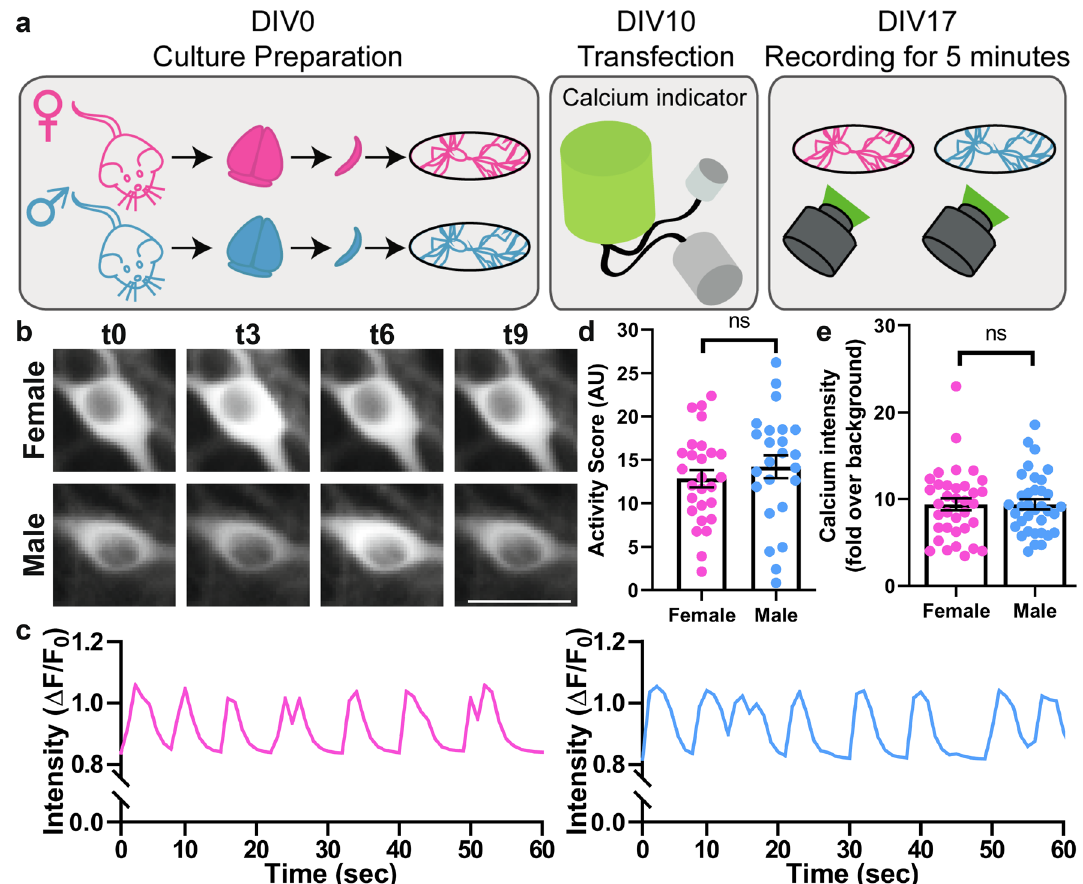
Figure 4. The spontaneous network activity does not show any sex-related differences. (a) To be able to study the sex-related differences in primary culture, we separated female and male neurons during the culture preparation. To determine the spontaneous firing rate, we transfected the neurons at day in vitro 10 (DIV10) with the genetically-encoded Ca 2+ indicator NeuroBurst. At DIV17, we imaged neurons for 5 min. (b) Exemplary 9 s-long calcium signals (t0-t9) images of female and male neurons. Scale bar: 20 µm. (c) Example calcium signals in male and female neurons, normalized to the baseline (ΔF/F0). (d) To compare the spontaneous calcium activity between the two sexes, we calculated the area under the curve of the intensity graphs, which we termed “activity score”, over 6 independent culture preparations that have 6 coverslips for each sex (N = 6, n = 36 independent experiments). The graph presents the activity score (mean ± SEM) and each symbol represents the mean activity score of a coverslip. Maximum 10 neurons were selected per coverslip. The